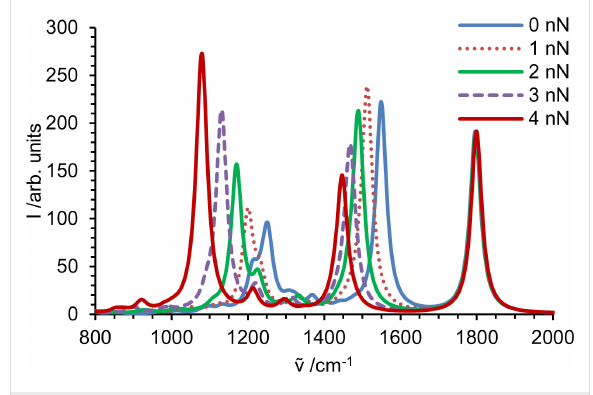
Figure 1: Force dependence of the modes shown in Scheme 1 in the fingerprint region from 800 to 2000 cm − 1 . C–N stretch of the amide bond (blue); backbone stretch combined with C–H 2 twisting (green); N–H wagging (orange); free C–O stretch (purple).